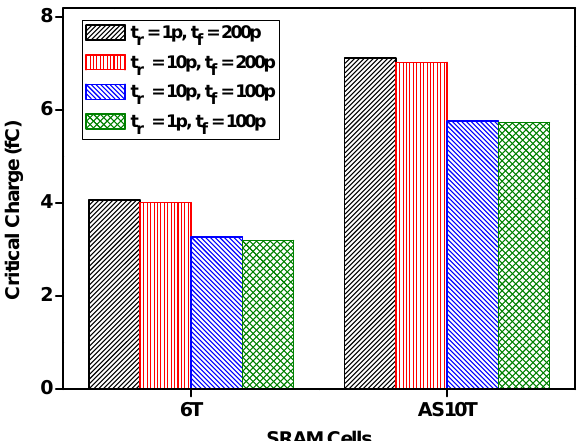
Figure 8. SEU effect on the observed critical charge of sensitive nodes of the SRAM cells simulated considering different rise times ( t r ) and fall times ( t f ) of the injected double exponential current pulse at the sensitive nodes.